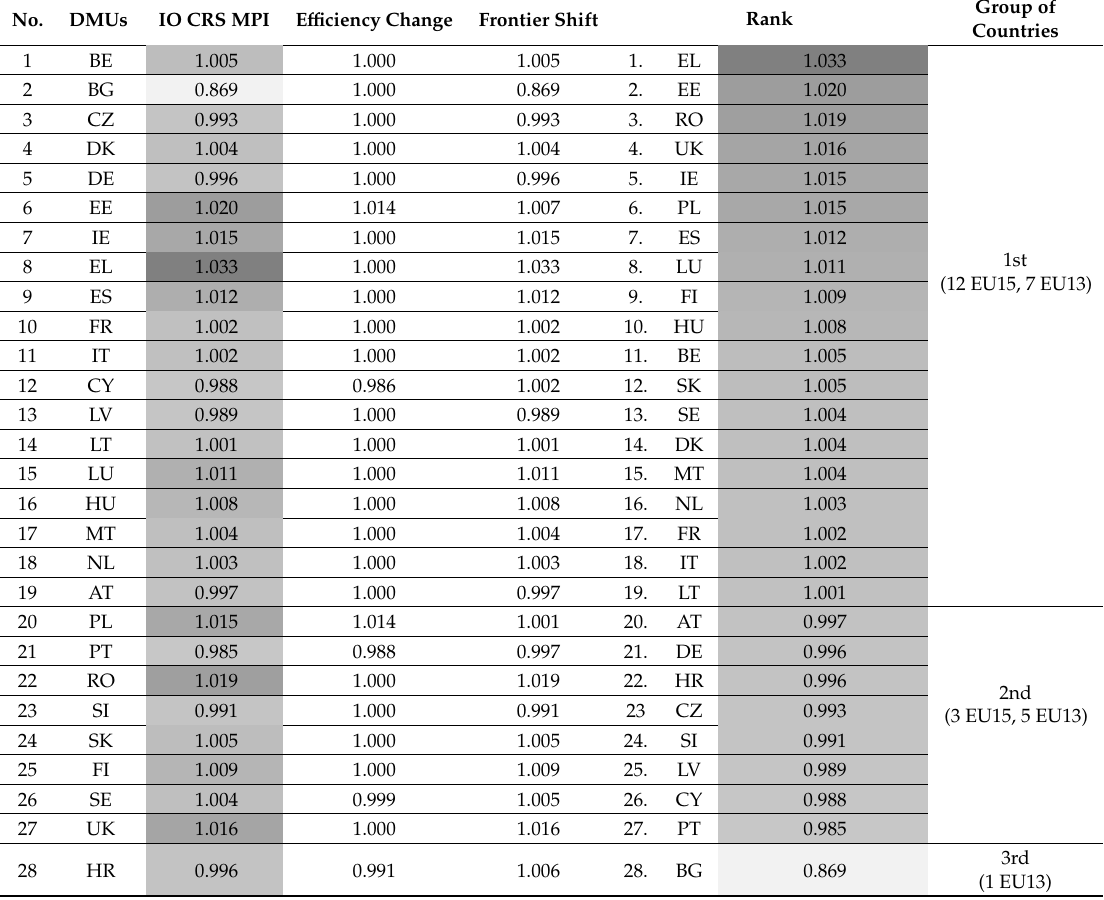
Table 10. MPI results for period 2012–2017 (source: own calculation and